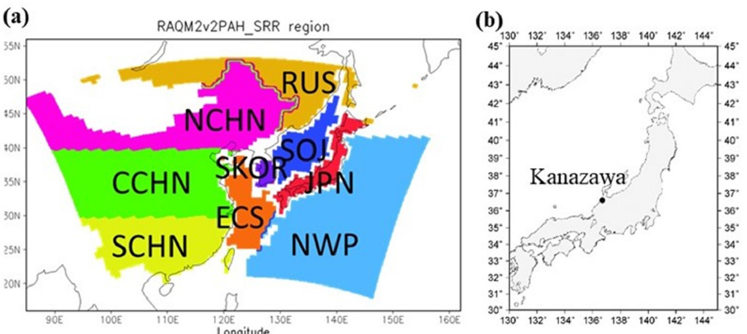
Figure 1. Source-receptor regions used in this study: ( a ) SRR domains in NE Asia; NCHN, north China (>40°N); CCHN, central China (30–40°N); SCHN, south China (<30°N); ERUS, eastern Asian part of Russia; SKOR, South Korea; JPN, Japan. The receptor regions are defined as the Yellow Sea and East China Sea (YEC), Sea of Japan (SOJ), and Northwestern Pacific Ocean (NWP). ( b ) Location of Kanazawa.